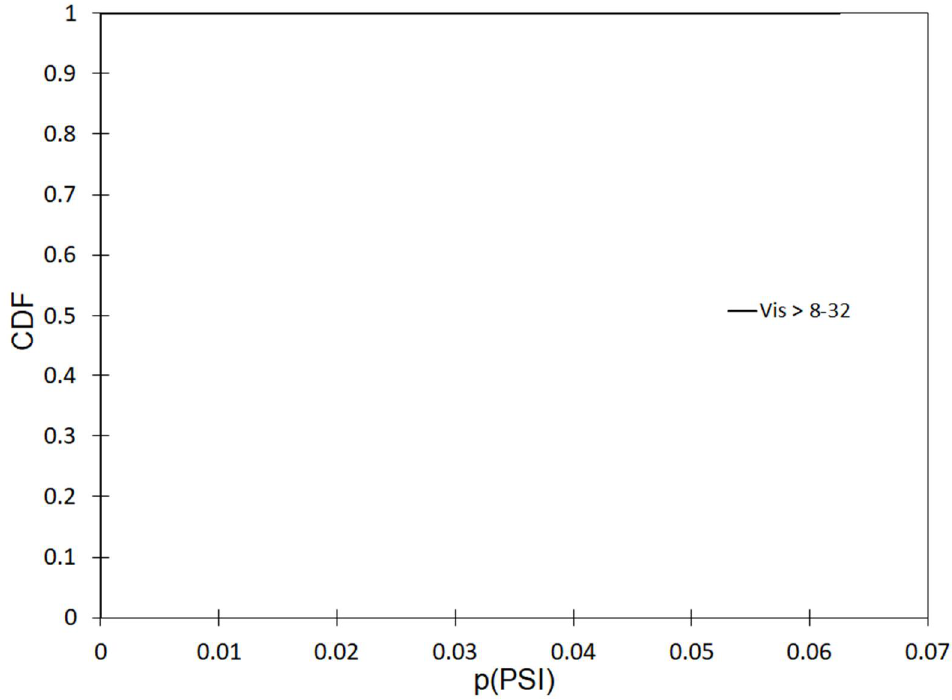
Figure A31. Effect of visibility on the incidence of very high winter mortality for rainy days.